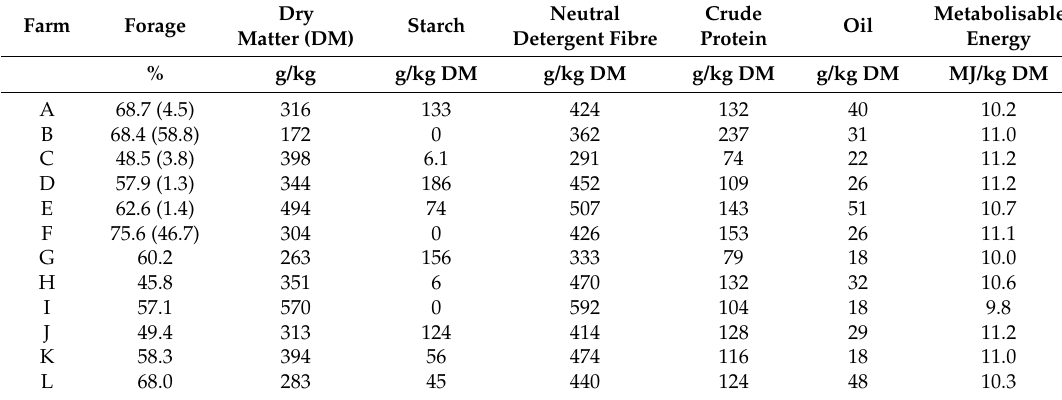
Table 2. Forage percentage (grass percentage in the diet and in parentheses) in the diet and forage nutrient content for each farm.